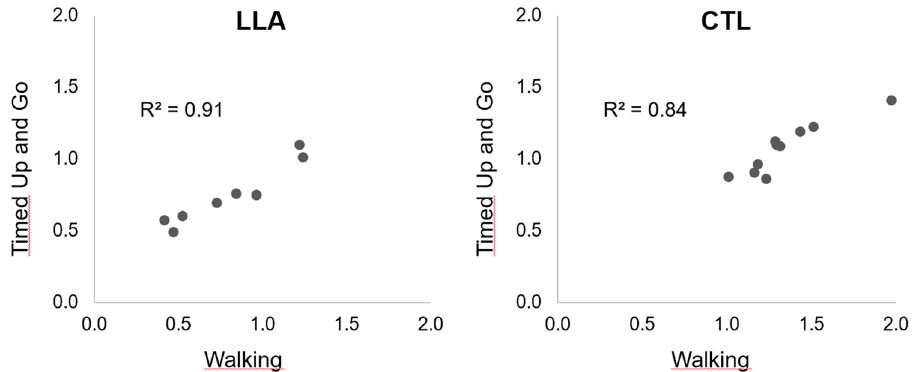
Figure 3. Relationship between the TUG and Walking MI/AE time ratios (each point represents the mean of all conditions for a given participant) in the LLA and CTL groups. Spearman’s Rho were statistically significant in both